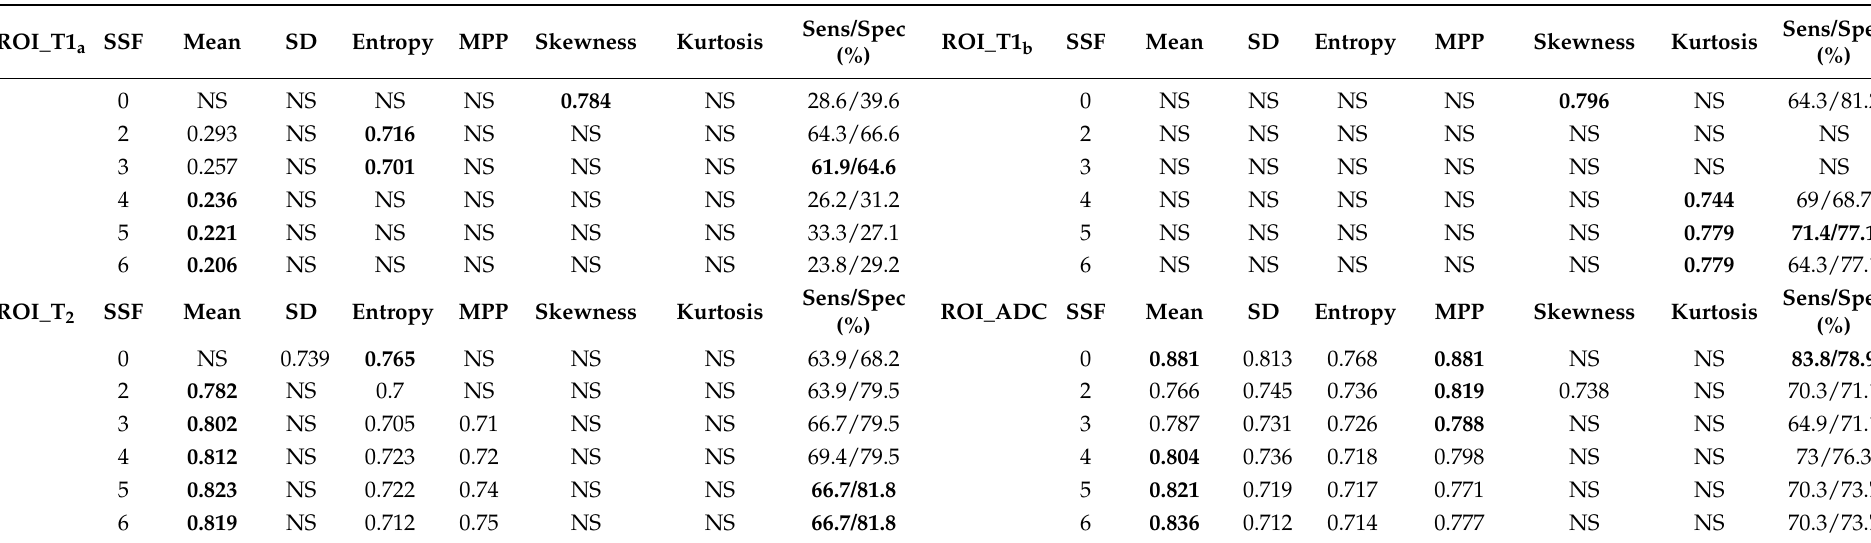
Table 2. MRTA analysis of all tumours (PCNSL n = 48 and GBM = 42).